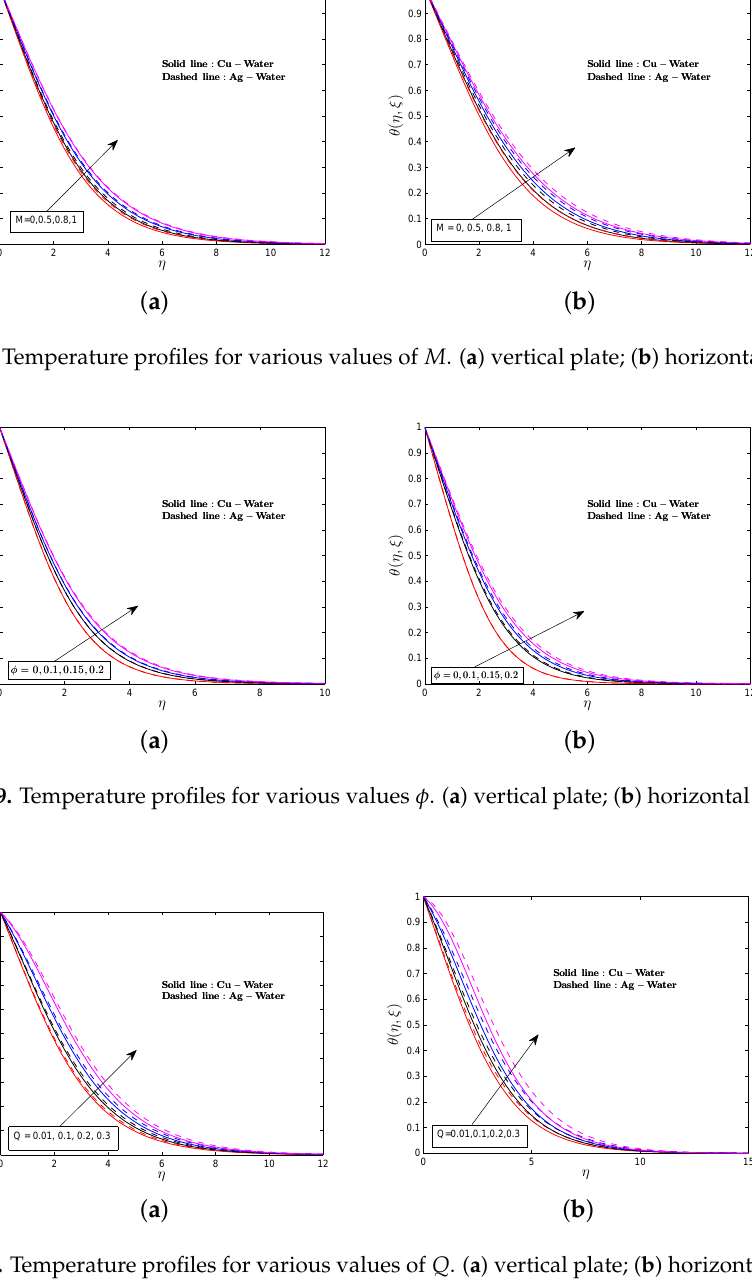
Figure 10. Temperature profiles for various values of Q . ( a ) vertical plate; ( b ) horizontal